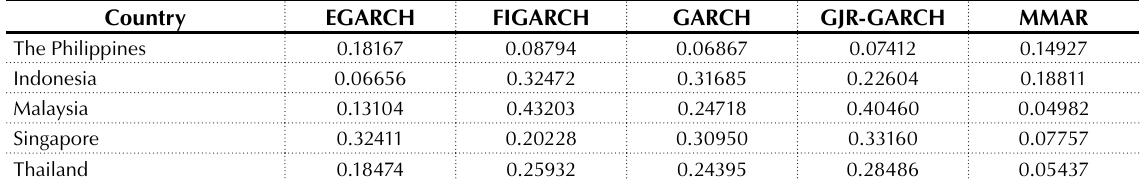
Source: Toggins (2008), Kim (2014).